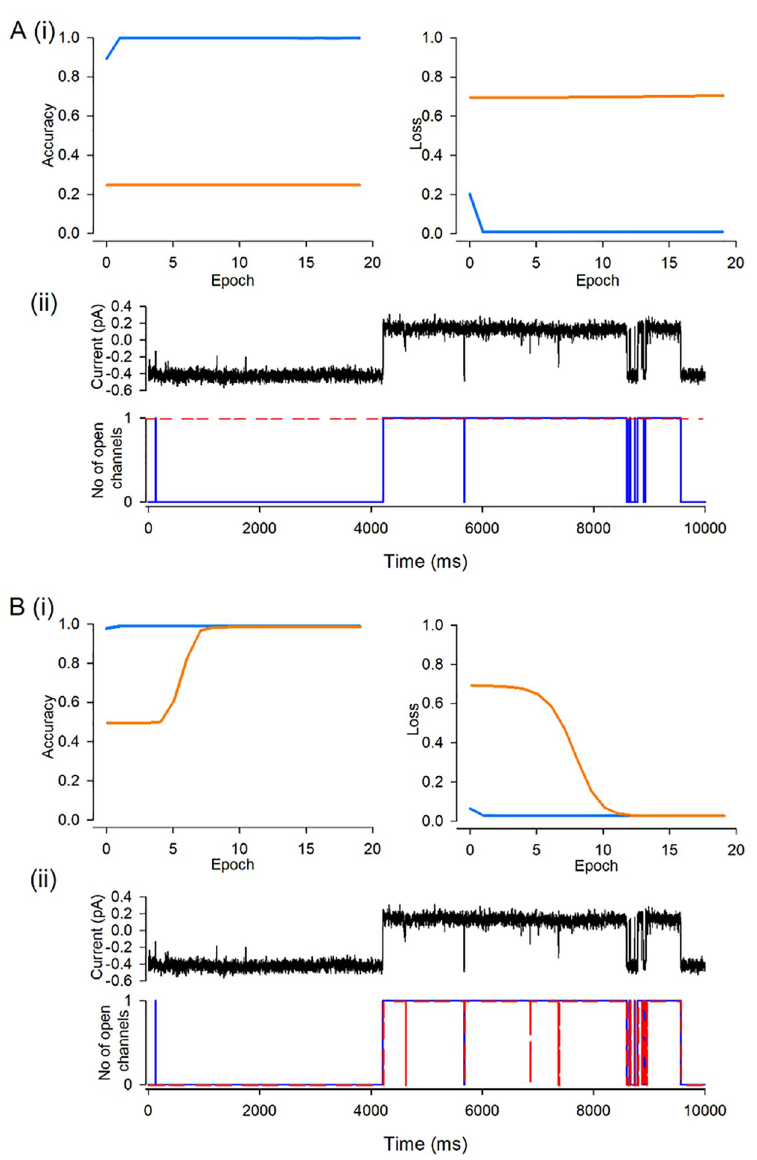
Fig 7. Potential of DeepGANnel to facilitate deep learning training on physiological time series data. This demonstration uses data from ion channel Phenotype C. The original raw data is 150k sample points. This was split into two 75k data sets, for training and for validation by our previously published labelling network Deep-Channel [13]. (A) Shows the training and validation accuracy; the accuracy on the training set itself is near perfect, but it fails to an accuracy of 0.5 (to predict open or closed) with the unseen validation dataset. (B) Shows similar to (A), but with losses. Complete failure with the unseen validation set. Ergo, model training fails as is illustrated in (C) where the raw signal (top) is shown above the synchronised ground truth black and prediction red. In the second part of this demonstration (D, E and F), we replace the training data with the GAN generated dataset of Phenotype C, which could be any length, but in this example is 5x larger than the original. Now Deep-Channel does much better. After about 5 epochs, performance against the validation dataset improves in terms of both accuracy (D) and loss (E) and the final product is well trained model (F). There is close agreement between the ground truth (black) and the prediction (red).